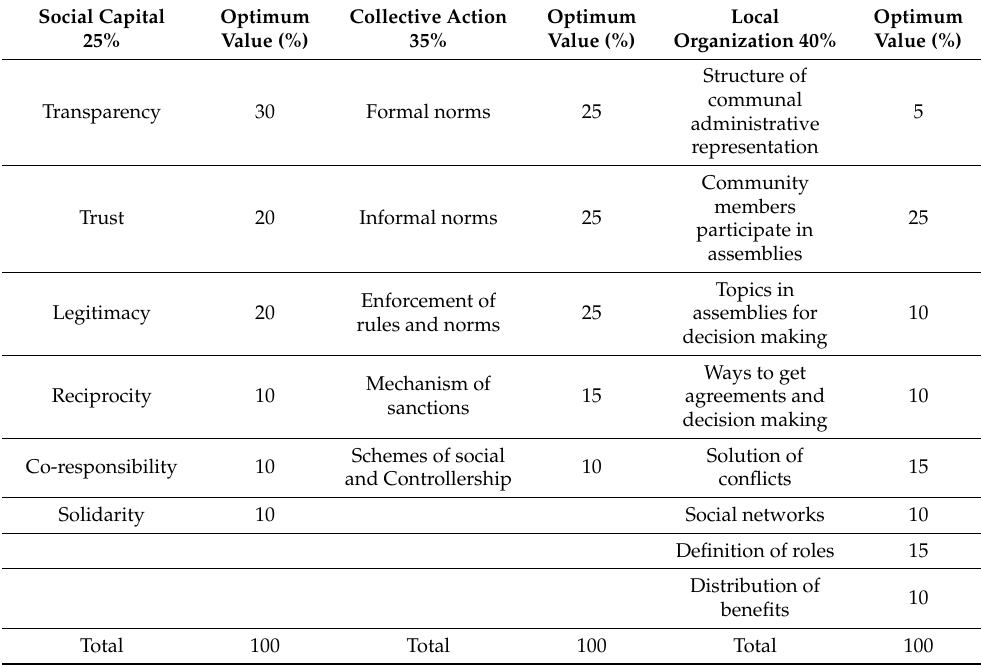
Table 2. Criteria and specific indicators to measure the level of community forest